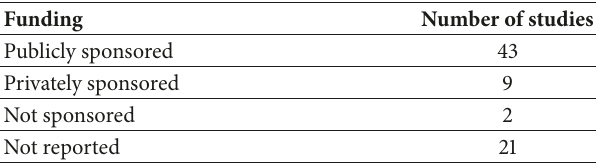
Table 4: Funding of included studies.